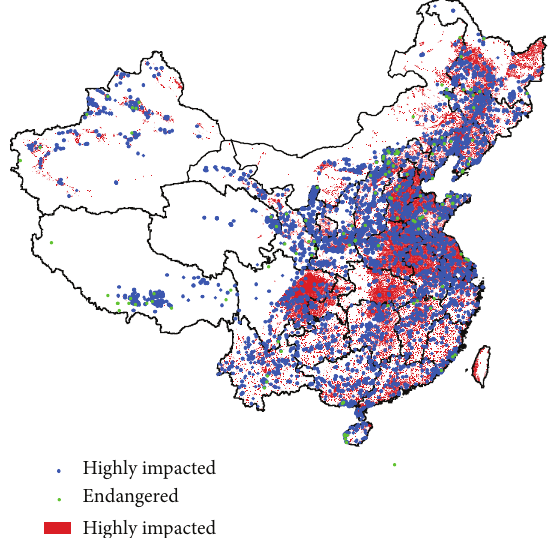
Figure 4: Soils that have 50% or more of their area impacted by construction and cultivation (the taxonomic level of the soil map is shown in Figure